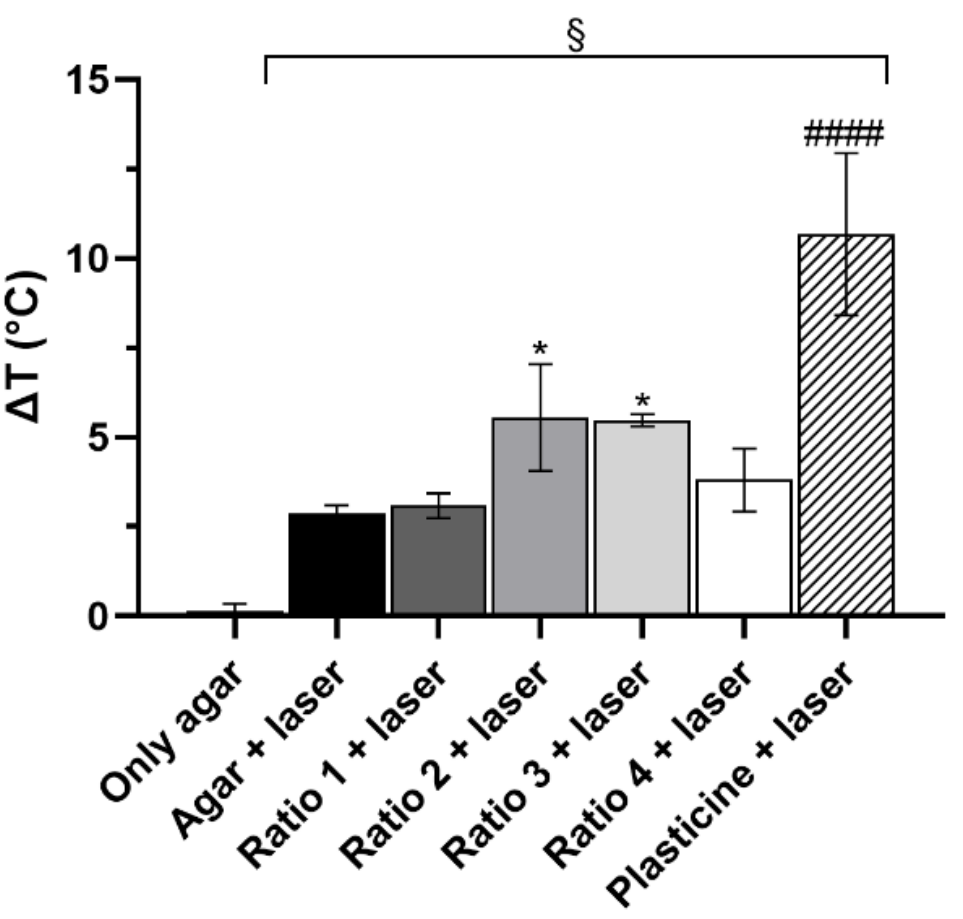
Figure 6. Phantom difference of temperature upon irradiation with a NIR laser for 3 min. The Au concentration in all 4 Ratios was the same as for the in vitro studies. The results represent the mean value ± SD, n = 4. Statistical significance represents: § p < 0.05 compared with the phantoms of only agar; * p < 0.05 comparing with the phantoms of only agar irradiated with the NIR laser; #### p < 0.0001 comparing with all the other phantoms.